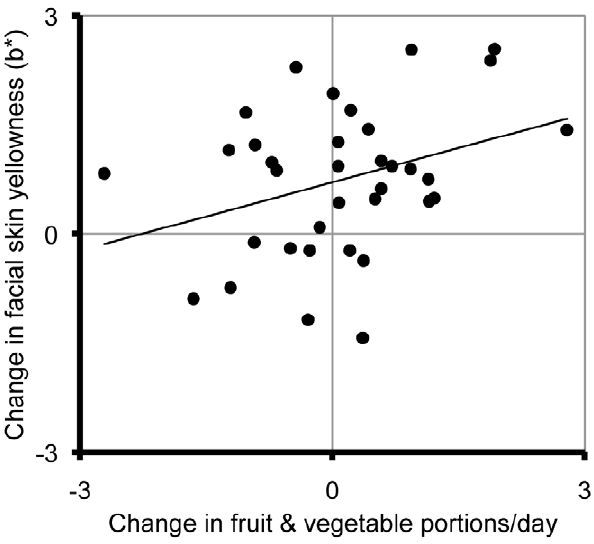
Figure 4. The relationship between six-week changes in fruit and vegetable intake and average facial skin yellowness (b*).